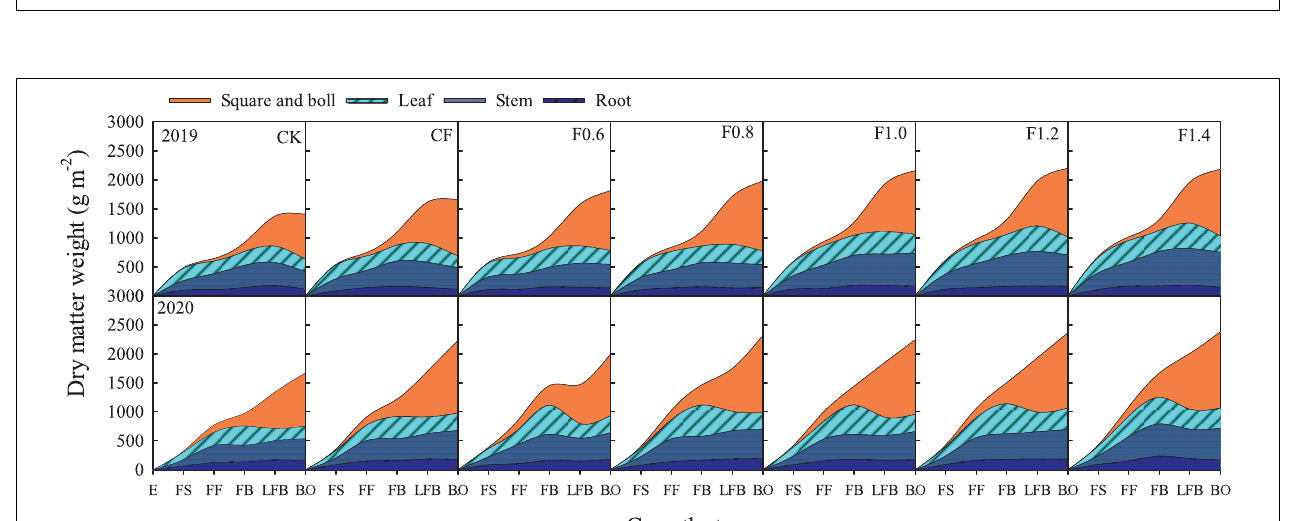
FIGURE 5 | The change in productive organ, leaf, and stem, and root dry mass (g m − 2 ). E, emergence; FS, full squaring stage; FF, full flowering stage; FB, full boll stage; LFB, later full boll stage; BO, boll opening stage.